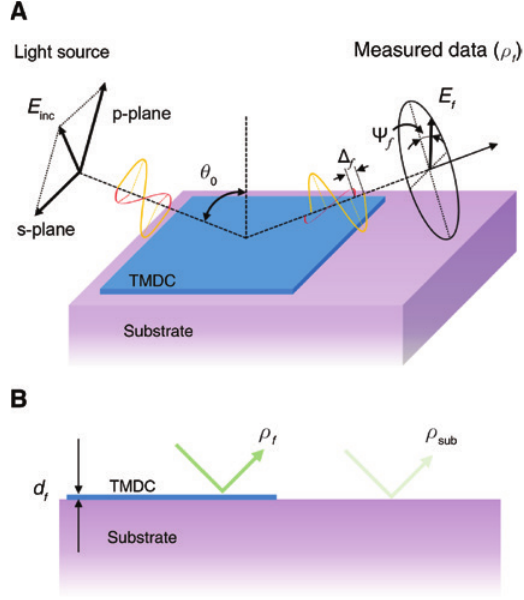
Figure 1: Principle of the deterministic permittivity measurement. (A) Schematic of the deterministic permittivity measurement of 2D materials. (B) Complex reflection ratio of the 2D thin film material of thickness d on the substrate ( ρ ) and of the bare substrate ( ρ ). E is f f sub f the reflected field when the incident field E impinges on the sample inc with the angle of incidence θ . Reflectivity can be characterized by 0 the reflection amplitude ratio tan( ψ ) and the phase difference Δ